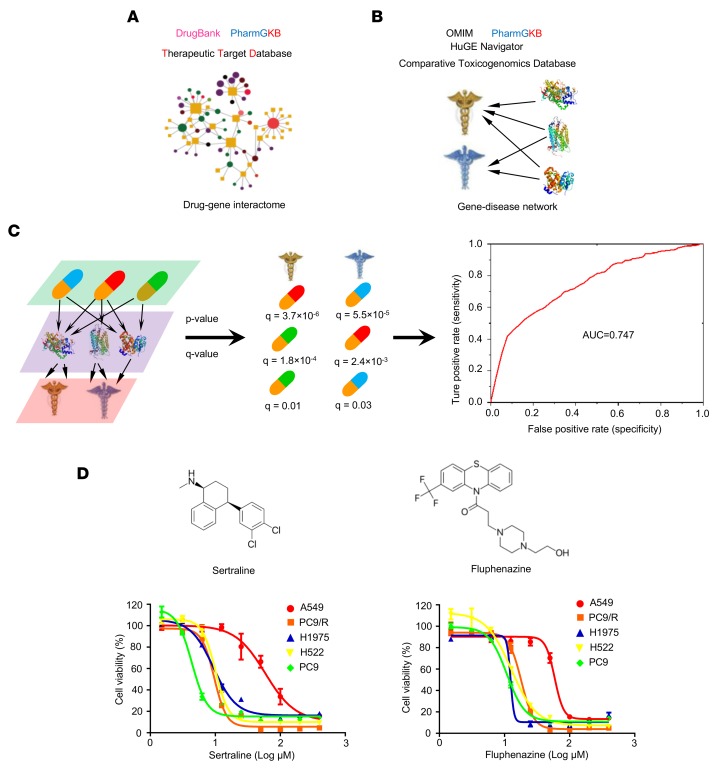
Diagram of medical genetics–based approach for drug repositioning.(A) A comprehensive drug-gene interactions (DGIs) was set up by integrating 3 public databases: DrugBank, PharmGKB, and Therapeutic Target Database. (B) A global disease-gene associations (DGAs) model was built by collecting data from 4 well-known data sources: the OMIM, HuGE Navigator, PharmGKB, and Comparative Toxicogenomics Database. (C) A new statistical model for predicting new indications for old drugs by integrating the DGIs and the DGAs. The performance of the medical genetics–based model was evaluated using a benchmark dataset. (D) The chemical structures and the dose-response curves of sertraline and fluphenazine in 5 representative NSCLC cell lines (A549, PC9, PC9/R, H1975, and H522) harboring different genetic characteristics. Cells were treated with a series of concentrations of sertraline or fluphenazine for 72 hours. The CellTiter 96 AQueous one solution cell proliferation kit was used to determine cell viability.